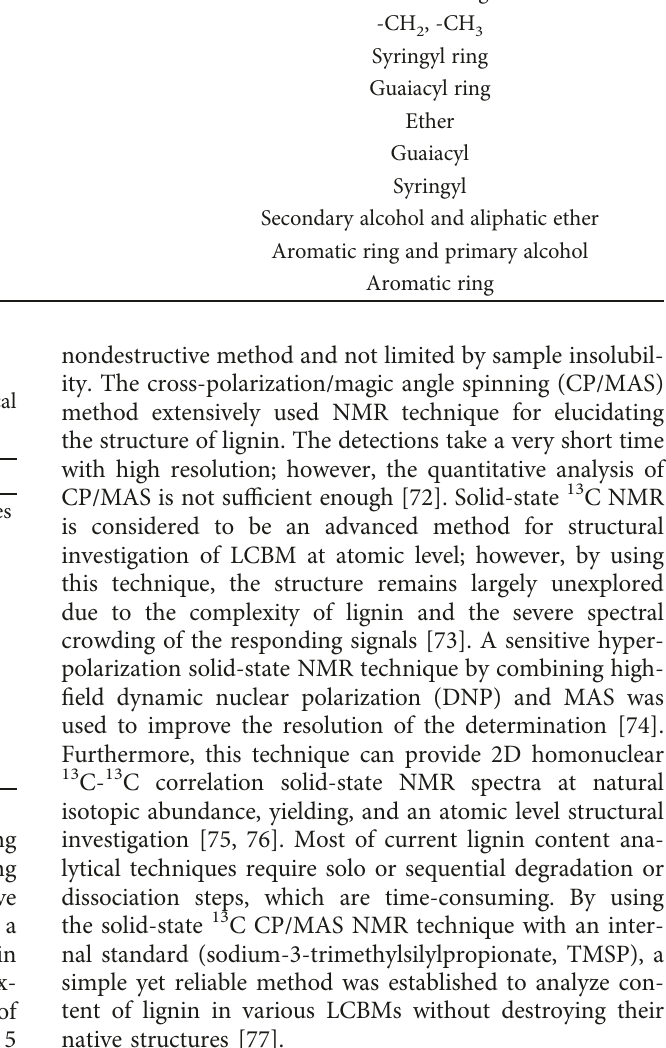
Table 2: Assignments of signals in FTIR spectrum to functional groups in lignin [25, 29, 38]. Wavenumbers/cm − 1 Assignments